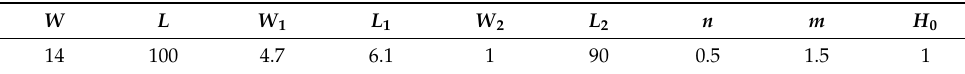
Figure 4. Structure diagram of the inquiry antenna. Table 2. Structure dimensions of the CPW antenna (unit: mm).